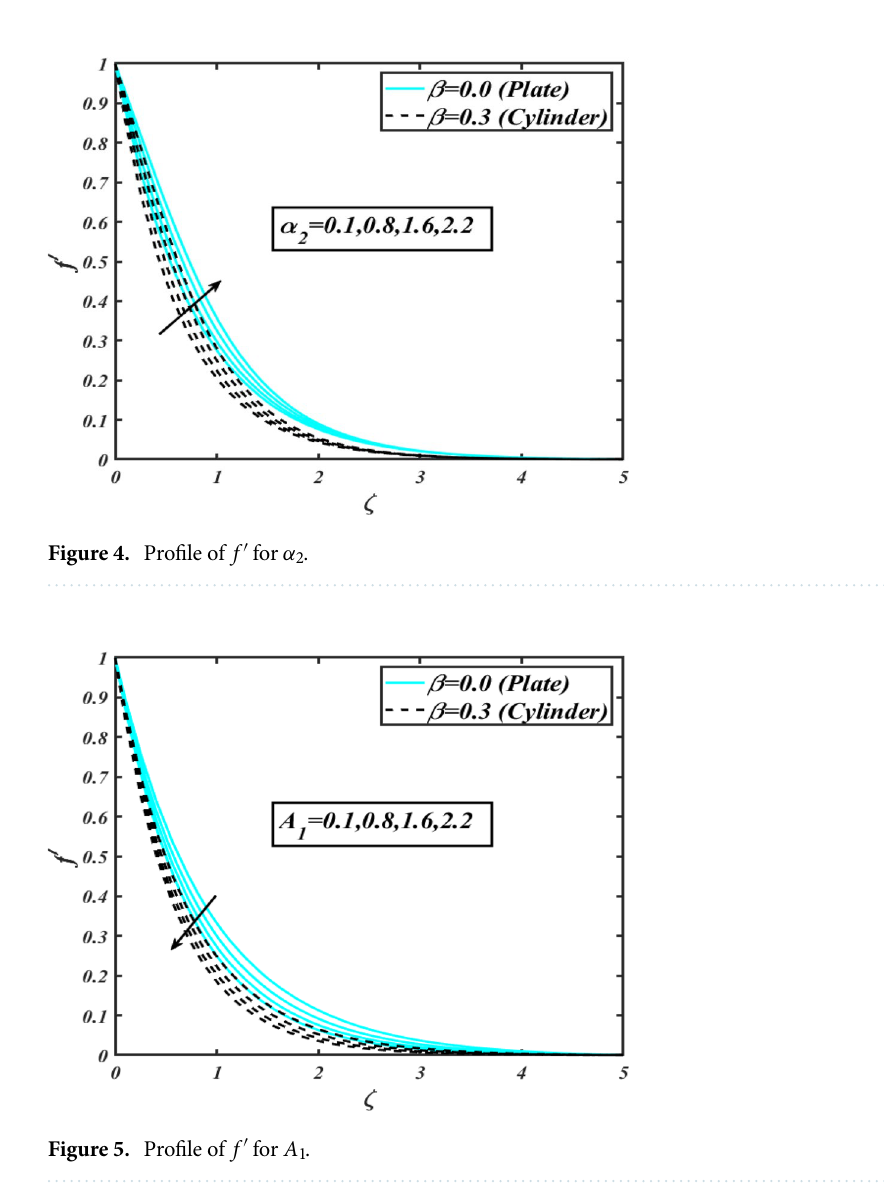
Figure 3. Profile of f ′ for α 1 .